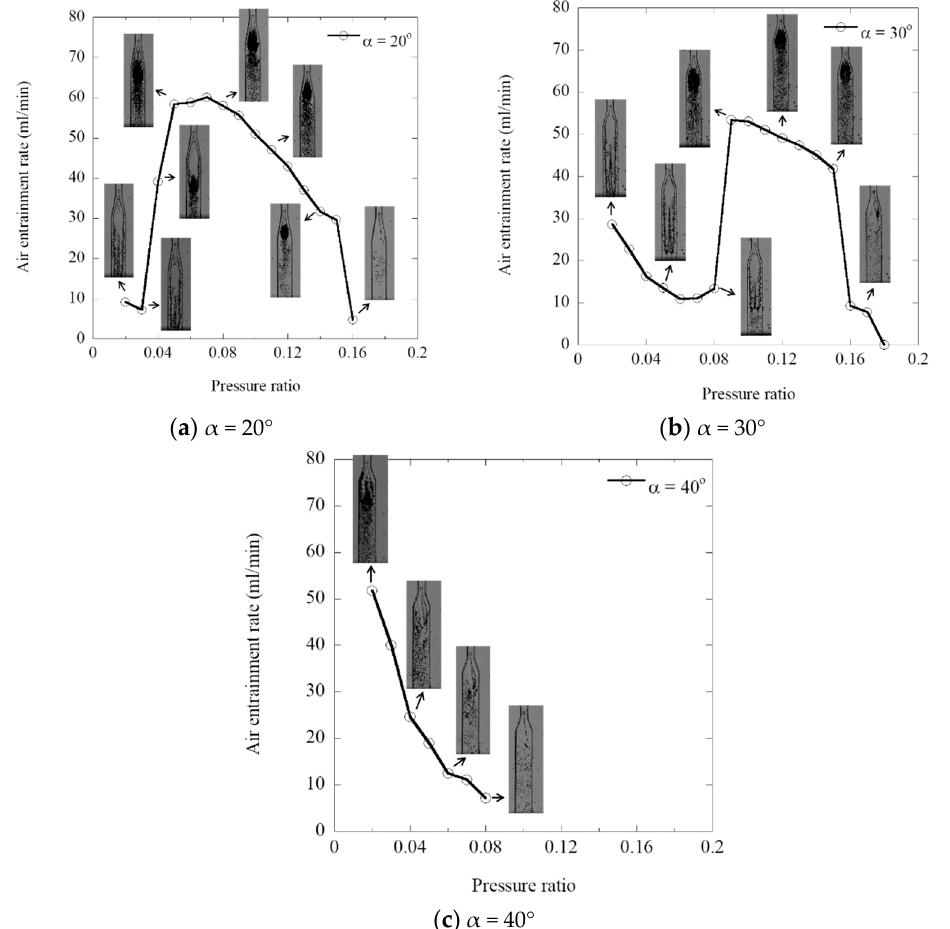
Figure 7. Air entrainment rate and behavior of a water–air two ‐ phase flow according to pressure ratio at the water flow rate of 700 mL/min: ( a ) α = 20°, ( b ) α = 30°, ( c ) α = 40°.